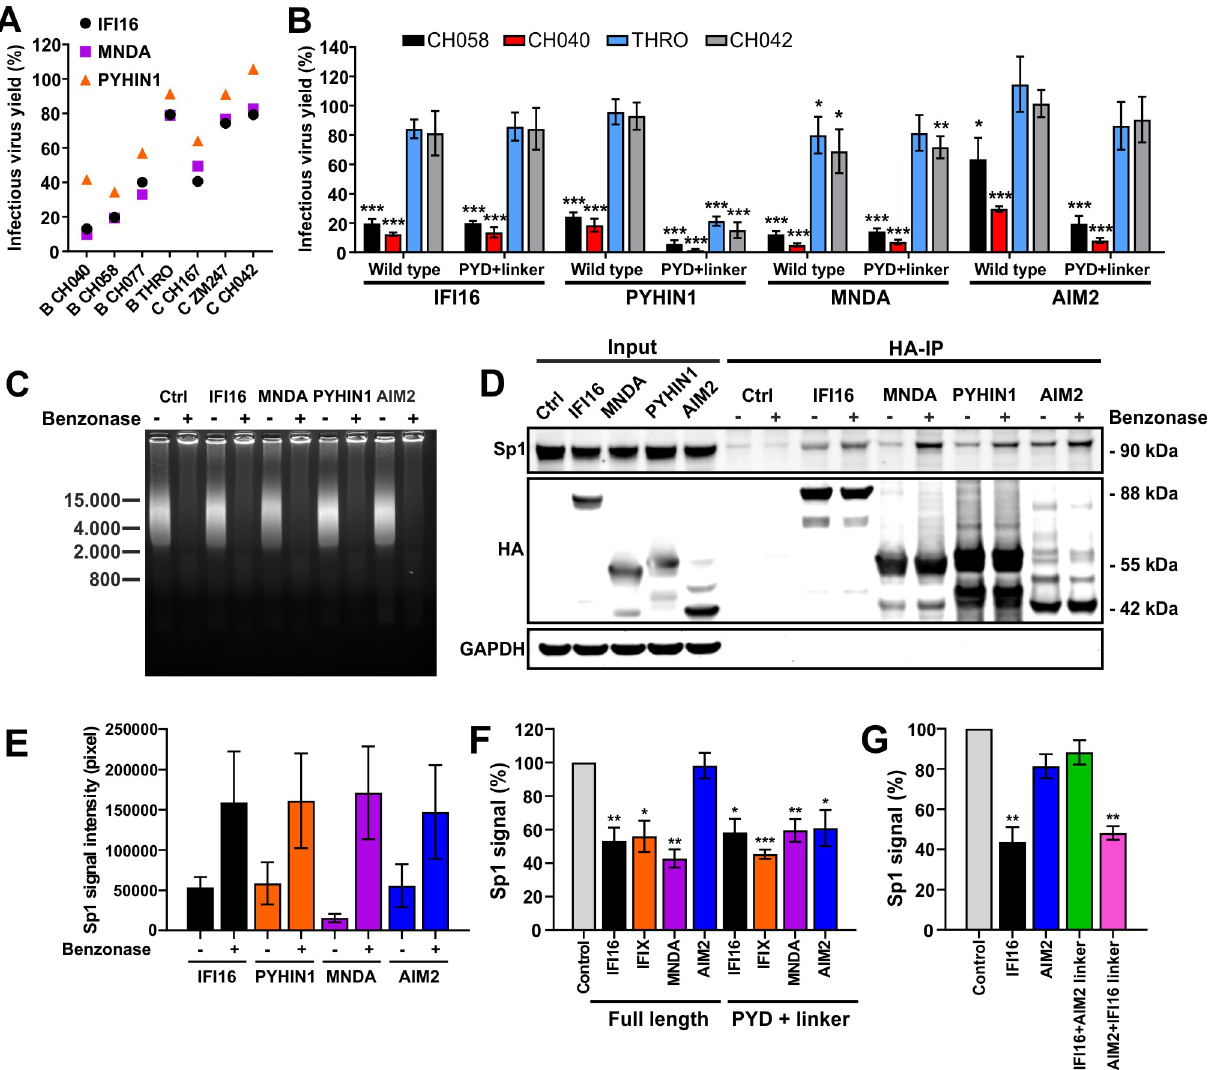
Fig 8. Human PYHIN proteins interact with Sp1 and reduce its availability. (A) Inhibition of different primary HIV-1 IMCs by human PYHIN proteins. HEK293T cells were cotransfected with the indicated proviral HIV-1 constructs and a control plasmid or vectors expressing IFI16, PYHIN1 or MNDA. Infectious virus yields in the presence of one PYHIN protein relative to the vector control (100%) was determined by infection of TZM-bl cells. Each symbol represents the average values obtained in three independent experiments. (B) The PYD plus linker region of IFI16, MNDA, PYHIN1 and AIM2 is sufficient for antiretroviral activity. HEK293T cells were transfected and analyzed for infectious virus yield as described in panel A. Shown are average values obtained from four experiments ( ± SD). � p < 0.05, �� p < 0.01, ��� p < 0.001. (C-E) PYHIN proteins compete with DNA for Sp1 binding. HEK293T cells were transfected with empty vector or expression constructs for the C-terminally HA-tagged PYHIN proteins. 40 hours post transfection, cells were lysed in Co-IP buffer and left untreated or treated with Benzonase before immunoprecipitating the PYHIN proteins using an anti-HA mouse antibody and magnetic beads. (C) Prior to immunoprecipitation, lysates were run on a 1% agarose gel to verify DNA degradation. (D) Proteins were blotted onto PVDF membranes and stained using anti-Sp1 goat, anti-HA rabbit and anti-GAPDH rat antibodies. (E) Mean Sp1 signal intensities ( ± SD) minus background control measured in three independent experiments. (F, G) HEK293T cells were transfected with expression constructs for the indicated PYHIN protein or their N-terminal PYD and linker regions. 40 hours later, cells were harvested and normalized quantities of nuclear extracts were used for the TransAM Sp1 binding assay (ActiveMotif). Data represent mean values ( ± SEM) obtained from three experiments. available Sp1 in nuclear extracts. In agreement with the antiviral activity, IFI16, MNDA and PYHIN1 reduced the levels of Sp1 bound to target DNA sequences while AIM2 had no signifi- cant effect (Fig 8F). In all cases, the PYD plus linker region of IFI16 were sufficient to reduce the levels of available Sp1 in nuclear extracts of transfected HEK293T cells. In addition, we